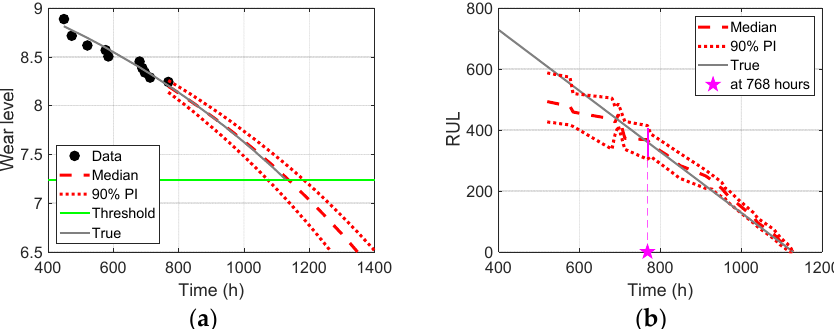
Figure 14. Prognostics results for the Maddock screw: ( a ) degradation prediction at 768 h; ( b ) RUL prediction for entire time.